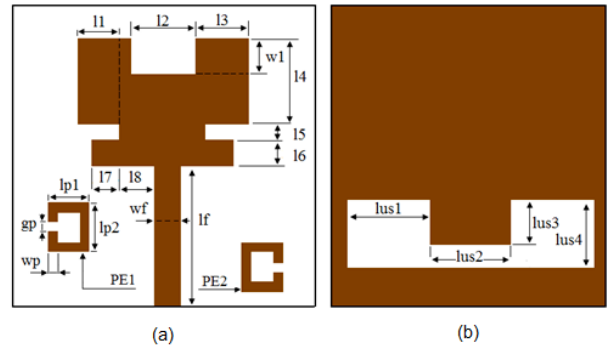
Figure 3. Geometry of the proposed quadruple-band microstrip antenna (a) Front view and, (b) back view.